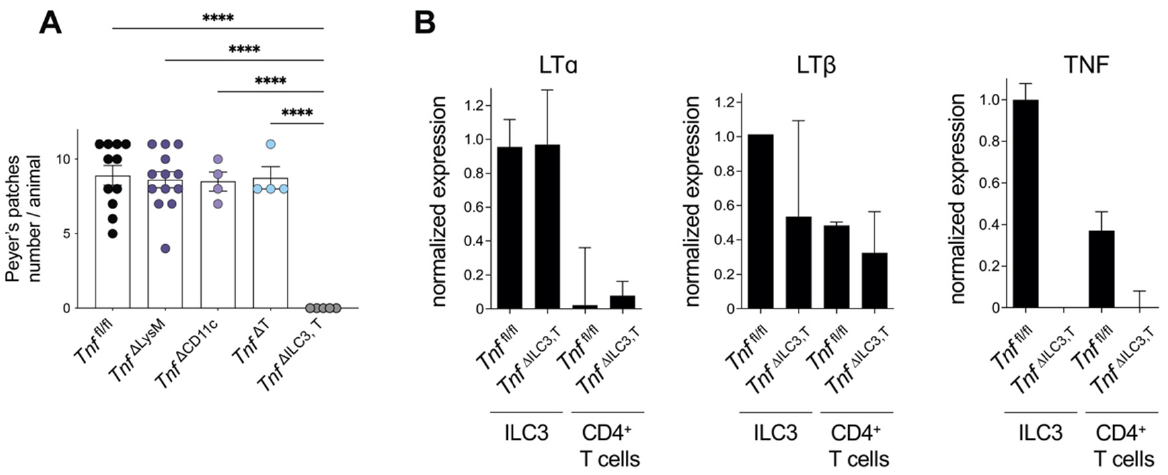
Figure 2. ILC3-derived TNF is critical for Peyer’s patches development. ( A ) Peyer’s patches numbers in adult Tnf fl/fl ( n = 11), Tnf ∆ LysM ( n = 13), Tnf ∆ CD11c ( n = 4), Tnf ∆ T ( n = 4), and Tnf ∆ ILC3,T ( n = 5) mice; ( B ) mRNA expression of LT α , LT β , and TNF in purified ILC3 and CD4 + T cells isolated from the spleens of Tnf fl/fl and Tnf ∆ ILC3,T mice. Each symbol represents an individual mouse; mean ± SEM. **** p < 0.0001 (one-way ANOVA).